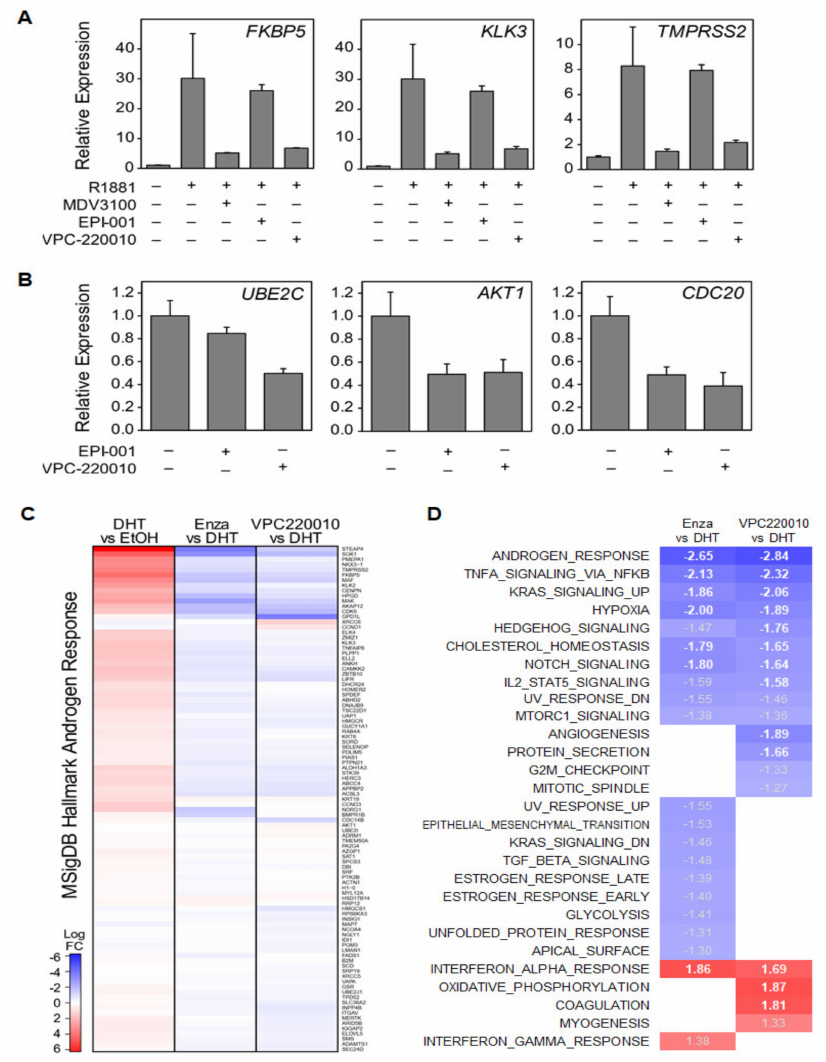
Figure 5. VPC-220010 inhibits the transcriptional activity of ( A ) canonical full-length AR-regulated genes KLK3, TMPRSS2 and FKBP5 in LNCaP cells; ( B ) ARV7-regulated genes UBE2C, AKT1 and CDC20 in ARV7 expressing cells 22rv1. ( C ) RNA-seq of VPC-220010 treated LNCaP cells demon- strated strong downregulation of the hallmark androgen response gene signature; ( D ) GSEA analysis of VPC-220010 treated LNCaP. A negative enrichment of genes associated with angiogenesis and protein secretion was observed in VPC-220010 but not